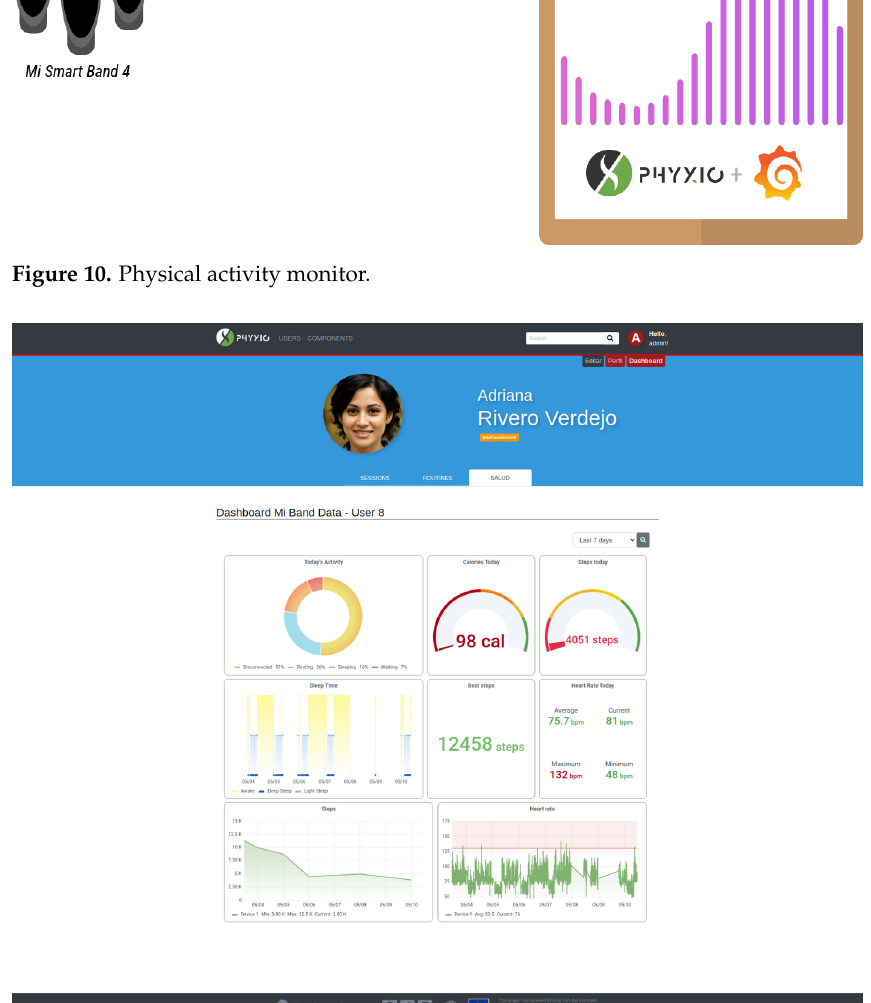
Figure 11. Dashboard of the physical activity